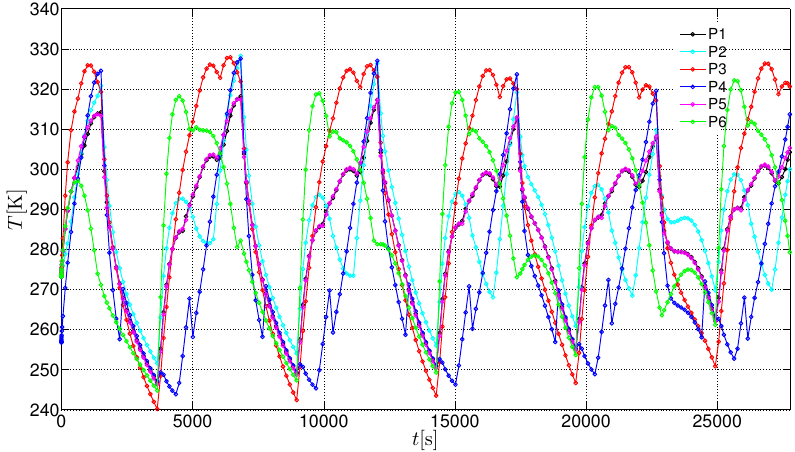
Figure 11. Average temperature in each composite panel as function of time ( β = 90 ◦